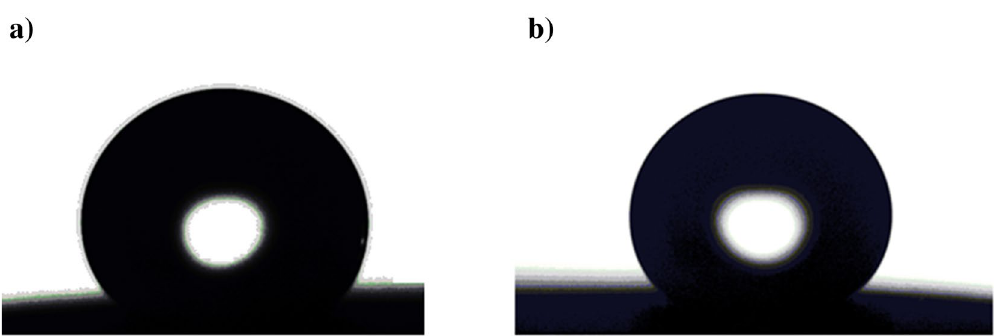
Figure 14. The shape of a water droplet on SHP coated steel by ( a ) Ni@G@MA, and ( b ) Ni@Cr-G@MA after the UV irradiation